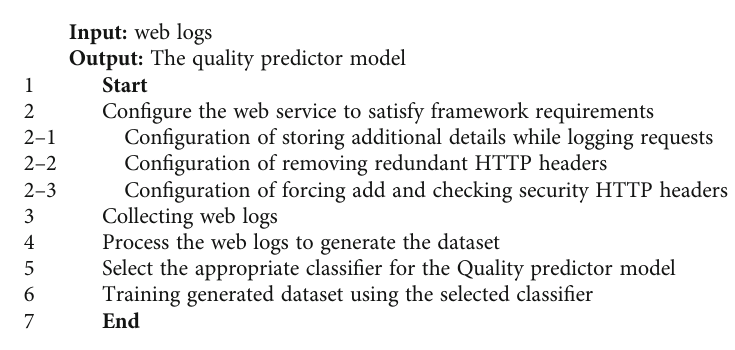
Figure 2: Default web service log and new log after con fi guring the web service with examples.